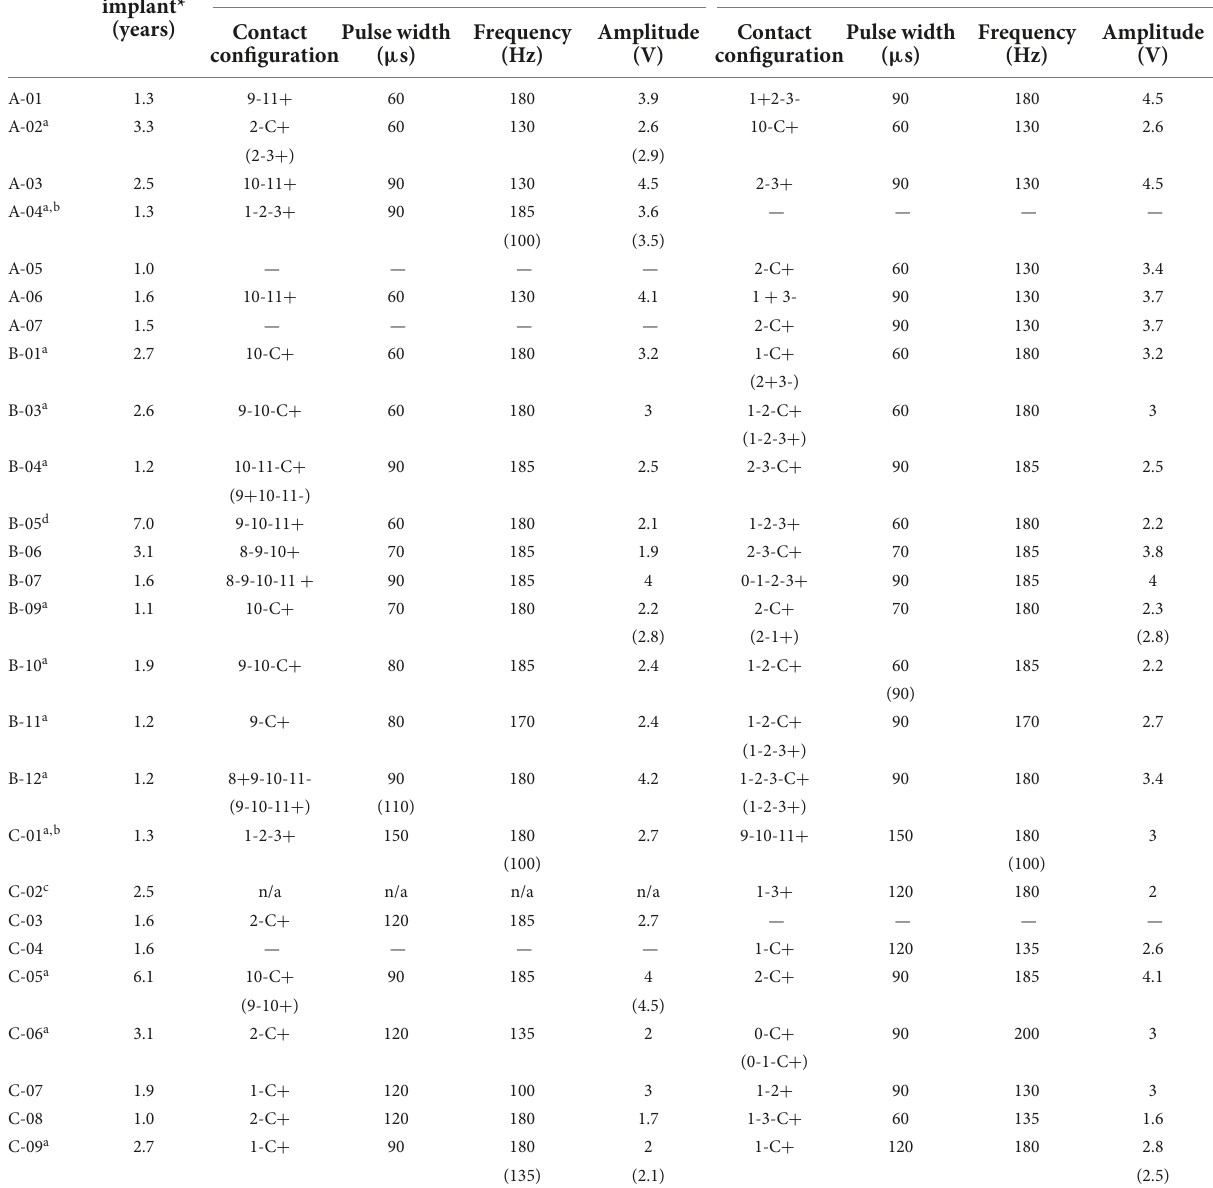
TABLE 2 Deep brain stimulation (DBS)